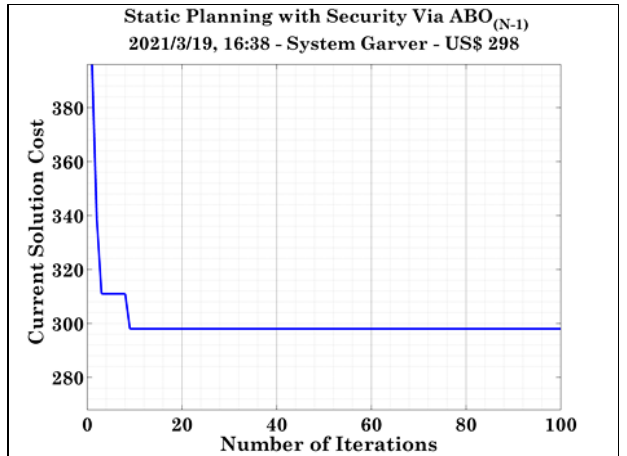
Figure 5: G-6/15 system: Cost evolution of the best